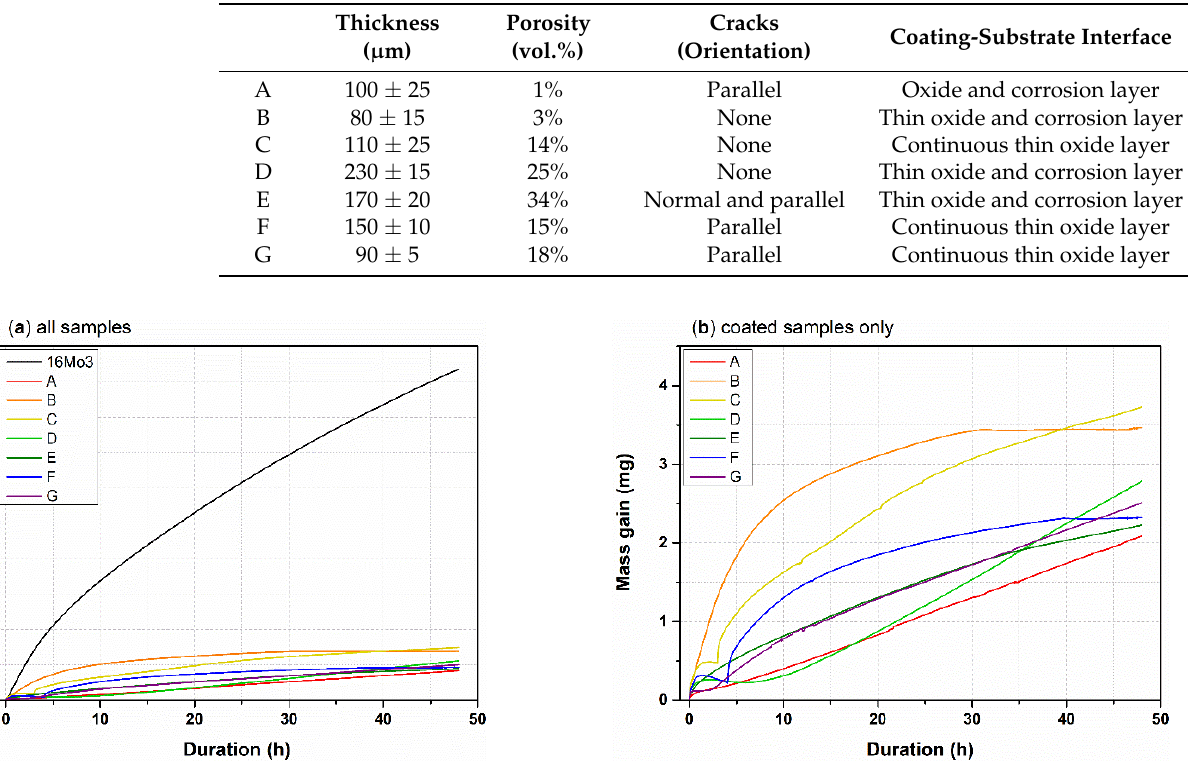
Figure 2. Specific mass gain curves obtained by TGA of ( a ) the raw material (reference 16Mo3) and coated samples exposed to Ar-10%H 2 O at 650 °C for 48 h; ( b ) presents the data of the coated samples only.